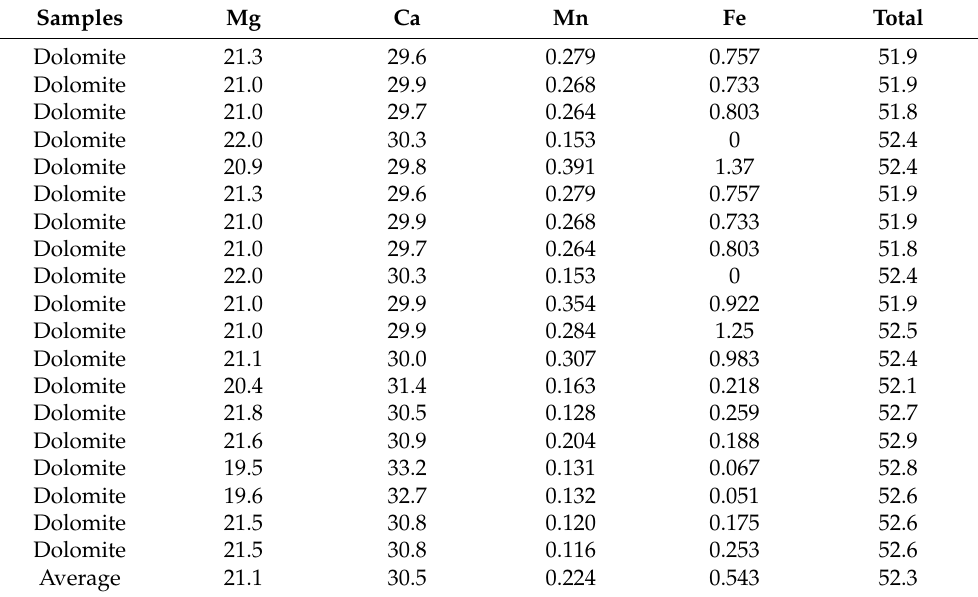
Table 4. Concentrations of major elements of dolomites in Zhinjin phosphorus rocks series measured using EPMA